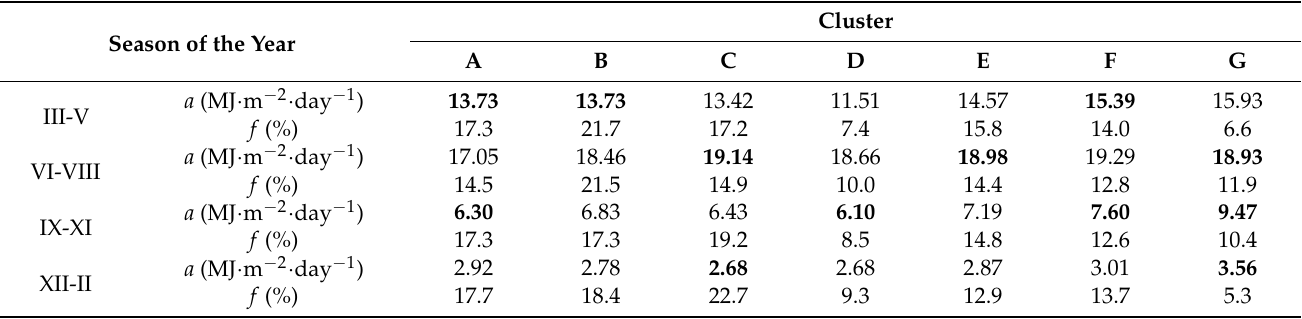
Table 2. The average daily sum of GSR, a (MJ · m − 2 · day − 1 ), over Poland during air inflow from individual clusters and the frequency, f (%), of air inflow from individual clusters in individual seasons of the year (III-V refers to spring, VI-VIII to summer, IX-XI to autumn, and XII-II to winter) during the period 1986–2015. Values that are statistically significantly different from the seasonal average of daily sums in the multi-year period 1986–2015 are in bold type ( α = 0.05). The letters indicating the clusters correspond to Figure